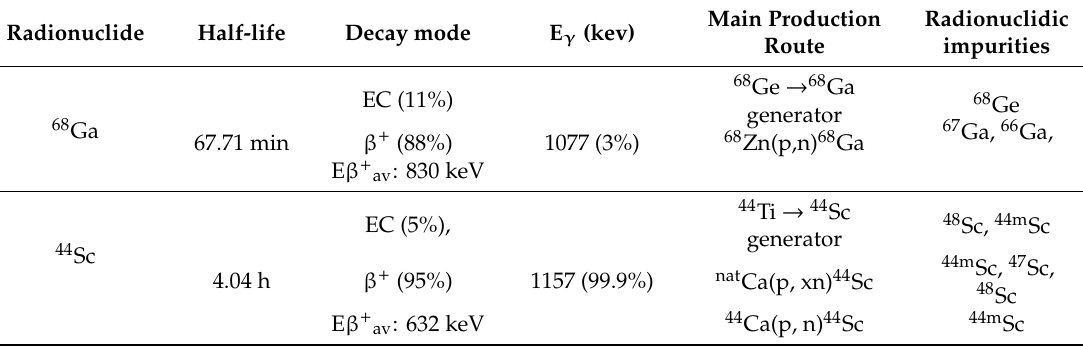
Table 2. Comparison of 44 Sc and 68 Ga decay characteristics and production routes.